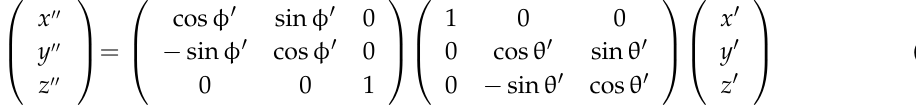
Table 2. Angles between incident ray and retroreflected ray γ with respect to δ , which is the dihedral angle of retroreflector corner cube surface with 90 ◦ as the